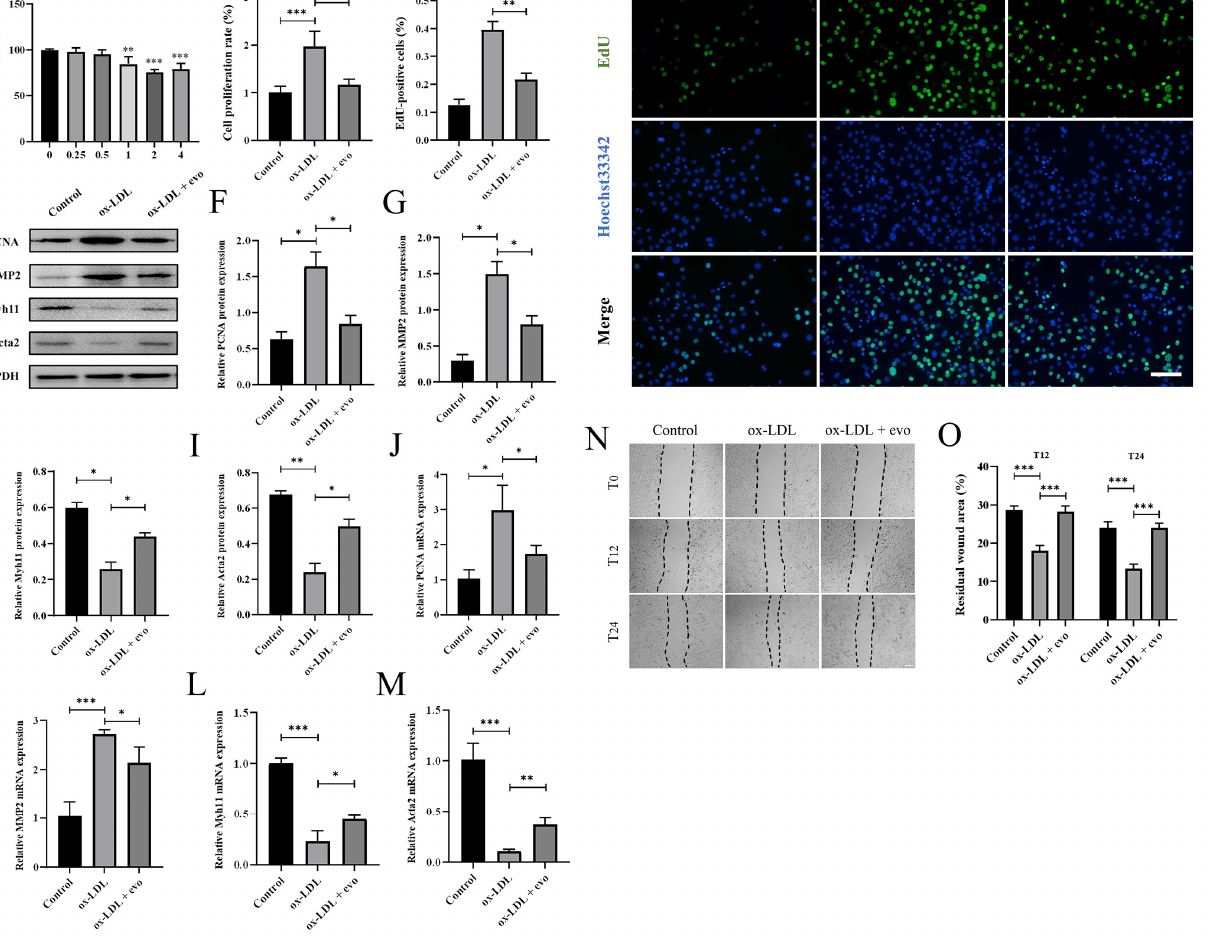
Figure 3. Analysis of proliferation and migration of atherosclerotic VSMCs in vitro: ( A ) the effect of different concentrations of evodiamine on cell viability was analyzed by CCK-8 assay. ( B ) Calculation of cell proliferation rate. ( C , D ) VSMC proliferation was quantified by EdU assay. Scale bar 100 µ m. ( E – I ) Representative images ( E ) and data of the protein levels of PCNA ( F ), MMP2 ( G ), Myh11 ( H ) and Acta2 ( I ). ( J – M ) The expression of PCNA , MMP2 , Myh11 , and Acta2 was quantified by qPCR and standardized to GAPDH . ( N , O ) Scratch test and blank area statistics. Scale bar 100 μ m. The bar graphs depict means ± SEM; statistical significance * p < 0.05, ** p < 0.01, and *** p < 0.001 by the one ‐ way ANOVA test.